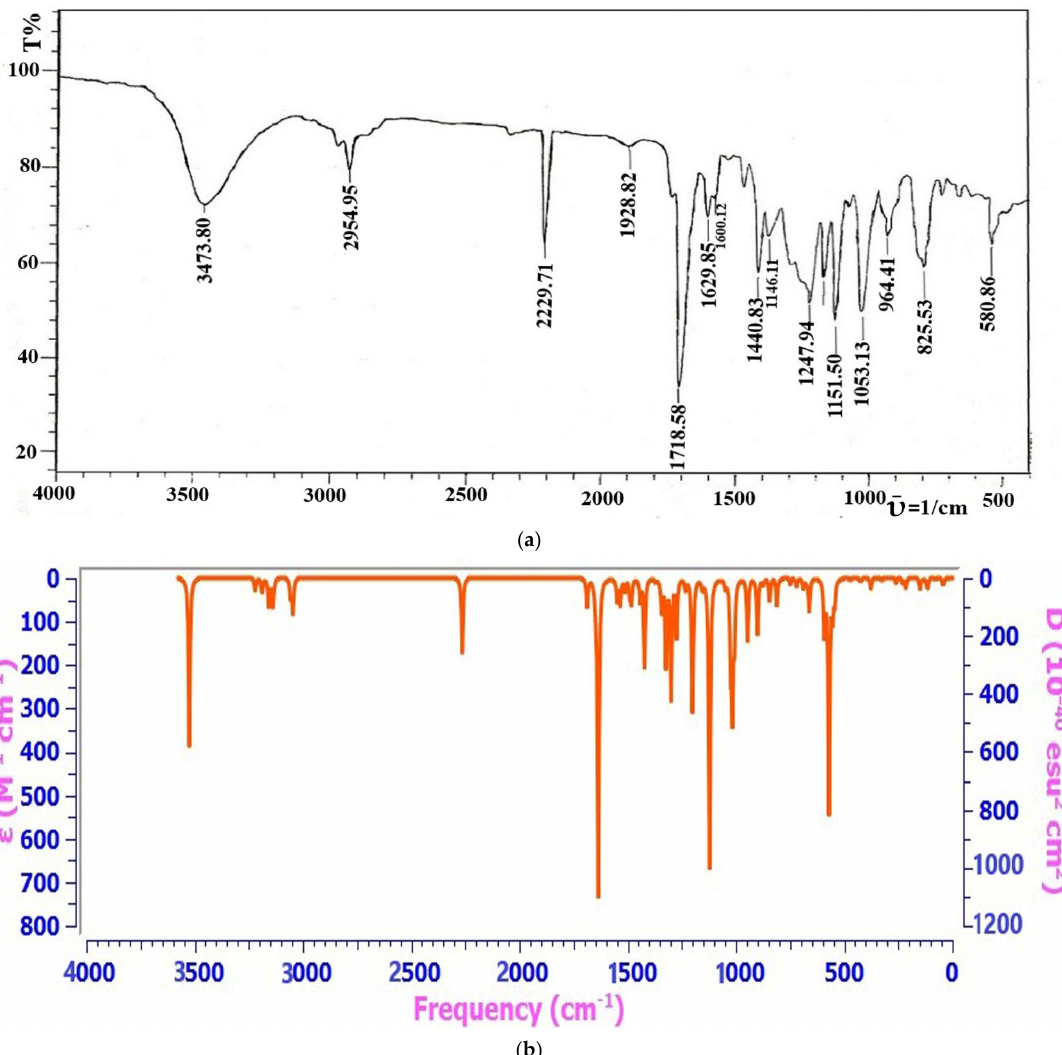
Figure 1. ( a ) Experimental FT-IR Spectrum of Compound 3. ( b ) Theoretical FT-IR Spectrum of Compound 3 .